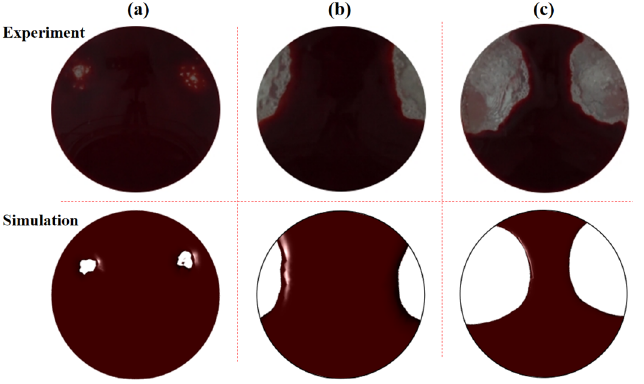
Figure 3. Comparison of open eyes at different flow rates: ( a ) 30 NL/min, ( b ) 90 NL/min, ( c ) 150 NL/min.